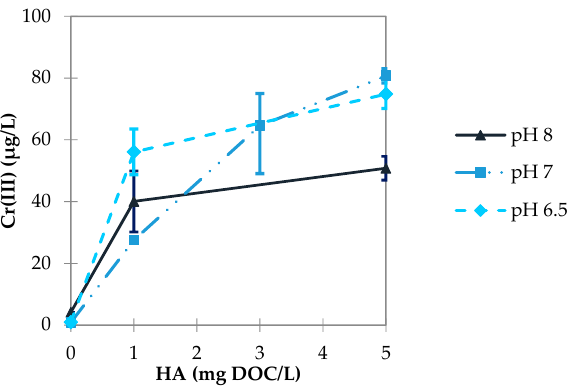
Figure 9. Cr(III) residual concentrations as a function of the presence of HAs (0, 1, 3, 5 mg DOC/L) at pH 6.5, 7, and 8 and at Fe(II) dosage 2 mg/L. Mean values with vertical bars indicate the respective range. The results were obtained by applying both set-ups A and B.